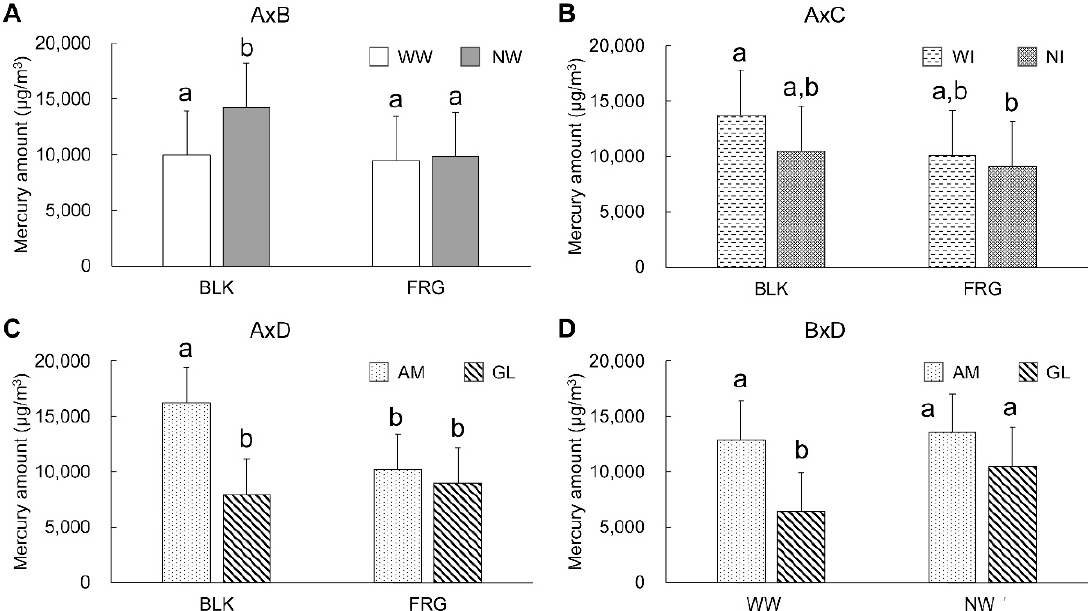
Figure 5. Mercury amounts in the system rinse water. Error bar indicates standard deviation. Same letter designation indicates nonsignificant difference ( p > 0.05). ( A ) Interaction of removal methods (block system: BLK, fragment system: FRG) with absence of cooling water (with cooling water: WW, no cooling water: NW), ( B ) Interaction of removal methods with absence of intraoral suction (with intraoral suction: WI, no intraoral suction: NI), ( C ) Interaction of removal methods with difference of drainage system (amalgam separator: AM, gas-liquid separator: GL), ( D ) Interaction of absence of cooling water with absence of intraoral suction. Table 3. The mean values and standard deviations of mercury amount of four-way ANOVA’s main factors in the system rinse